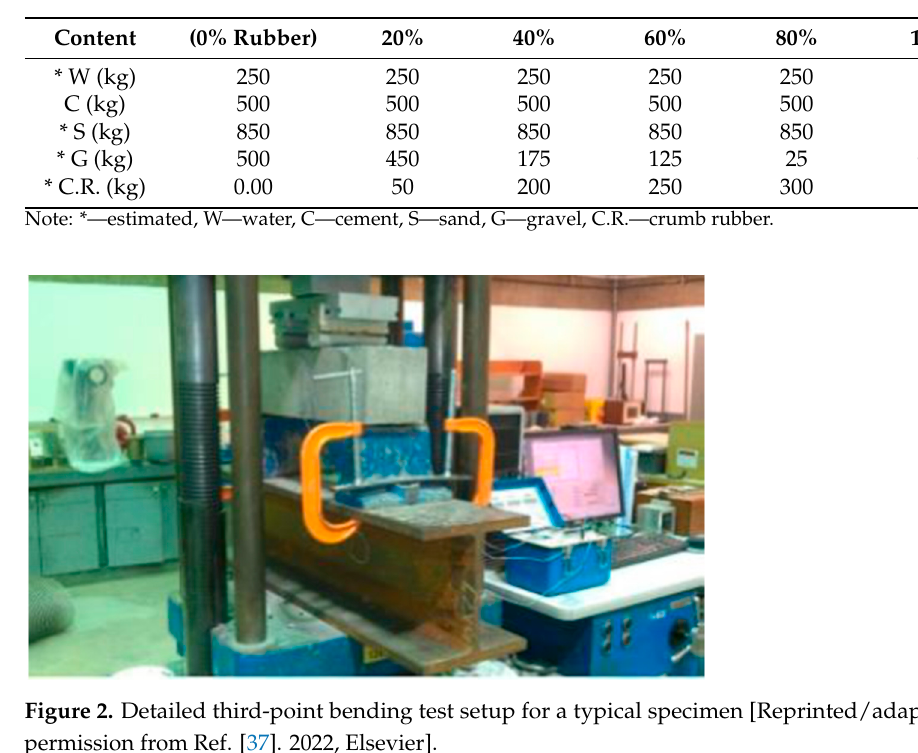
Table 1. Mix designs of the tested rubber concrete [37].